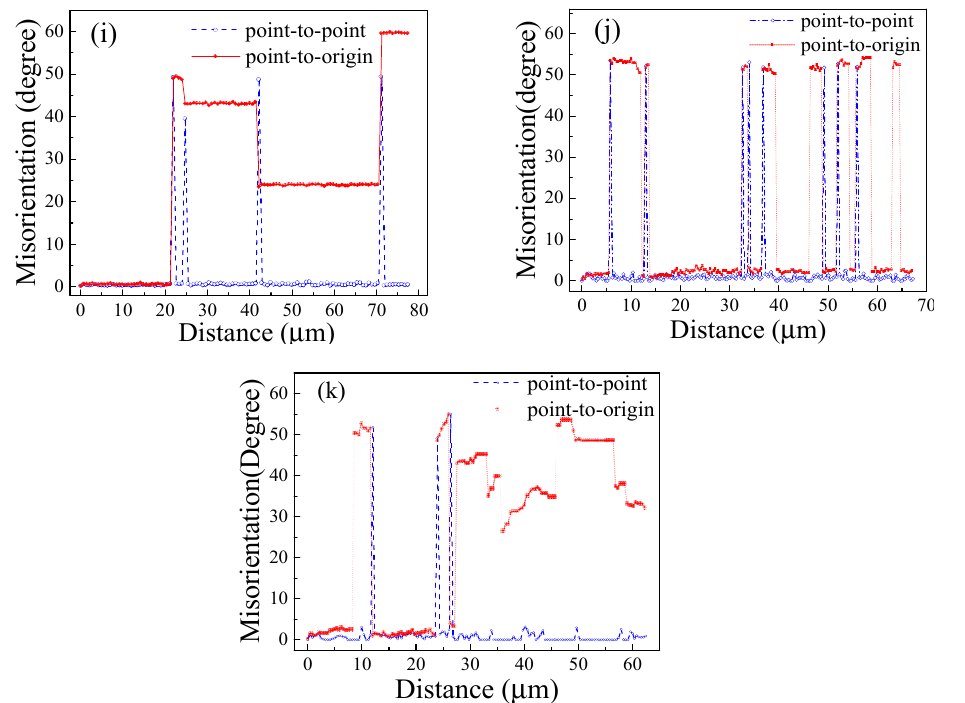
Figure 2. Mappings of orientation and coincidence site lattice corresponding to Figure 1. Among them, ( a – b ) correspond to location 1, ( c – d ) correspond to location 2, ( e – f ) correspond to location 3, and ( g – h ) correspond to location 4 in Figure 1, ( i – k ) misorientation profile along the arrow line 1, 2, and 3 in ( c ), ( e ) and ( g ),